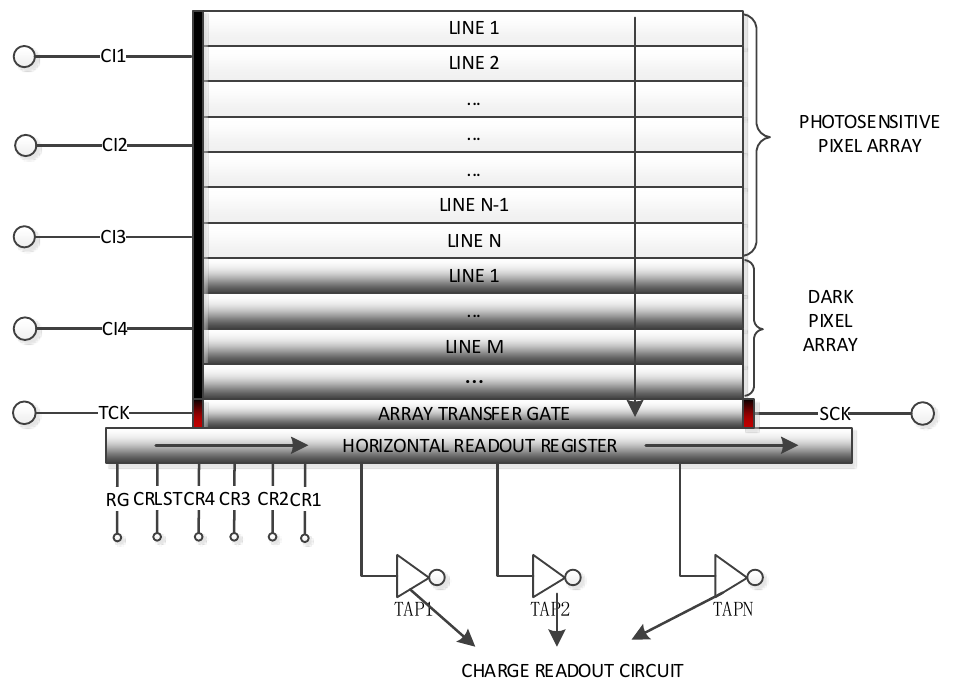
Figure 2. Sketch of TDICCD structure